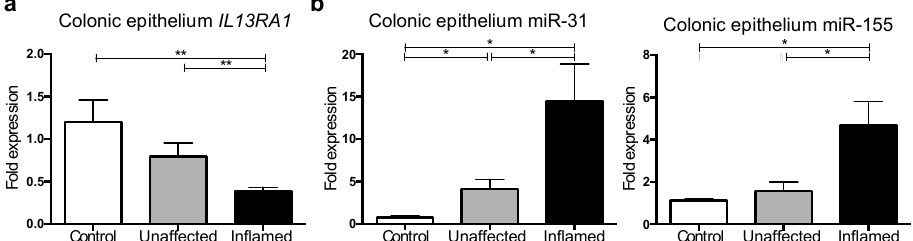
Figure 4. Interleukin-13 receptor α -1, miR-31 and miR-155 expression in primary gut epithelial cells: ( a ) Expression levels of IL13RA1 mRNA in colonic epithelial cells extracted from patients gut biopsies from non-UC patients (Control), unaffected tissue (Unaffected) and their matched inflamed colonic tissue samples taken from the same patient (Inflamed) relative to Control ( n = 5 on each group); and ( b ) miR-31 and miR-155 expression levels in gut epithelial cells isolated from biopsies taken from non-UC patients (Control, n = 3), unaffected tissue (Unaffected, n = 5) and their matched inflamed colonic tissue samples taken from the same patient (Inflamed, n = 5) relative to Control. Represented are mean + standard error of the mean. *: p -value ≤ 0.05; **: p -value ≤ 0.01.